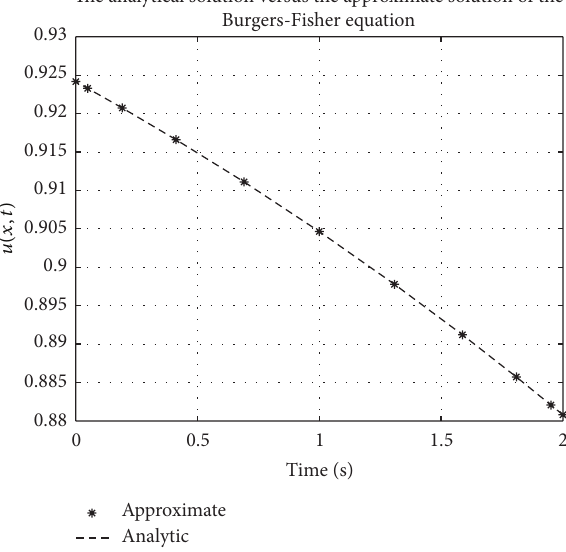
Figure 2: Burger-Fishers equation analytical solution graph.